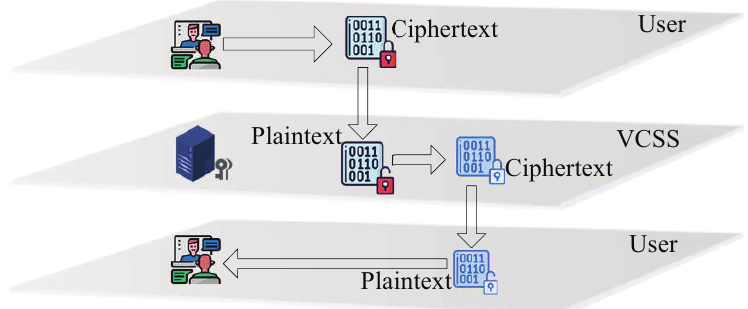
Figure 4. Data transmission between users.